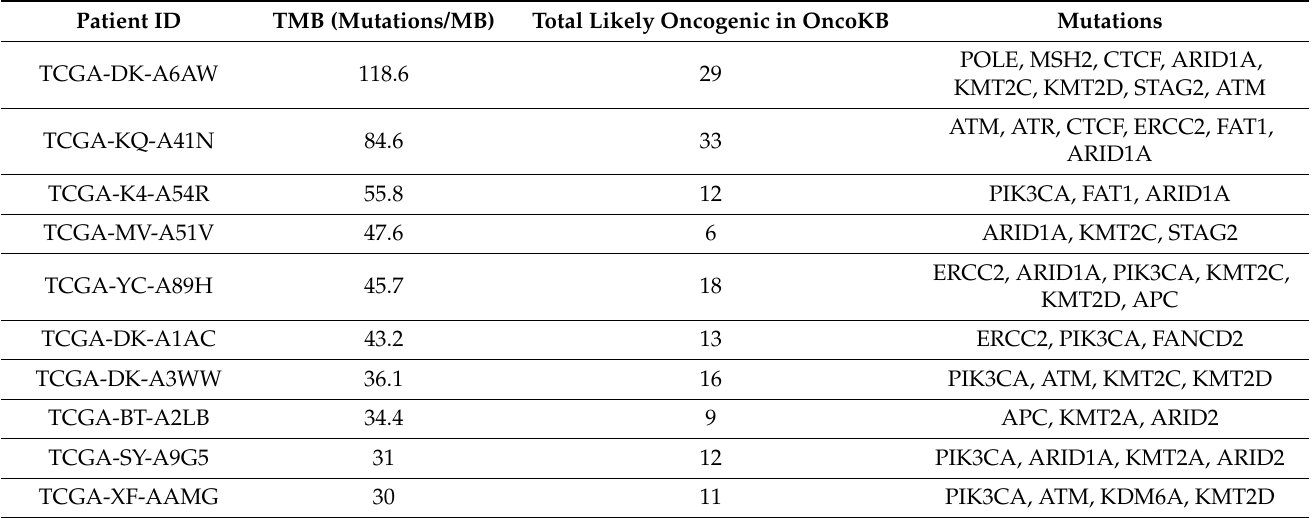
Table 4. Hypermutated cases with TMB ≥ 30 mutations/MB. The third column presents the total number of mutations in each case estimated as likely oncogenic in the OncoKB knowledgebase and the fourth column presents examples of genes with likely oncogenic mutations.